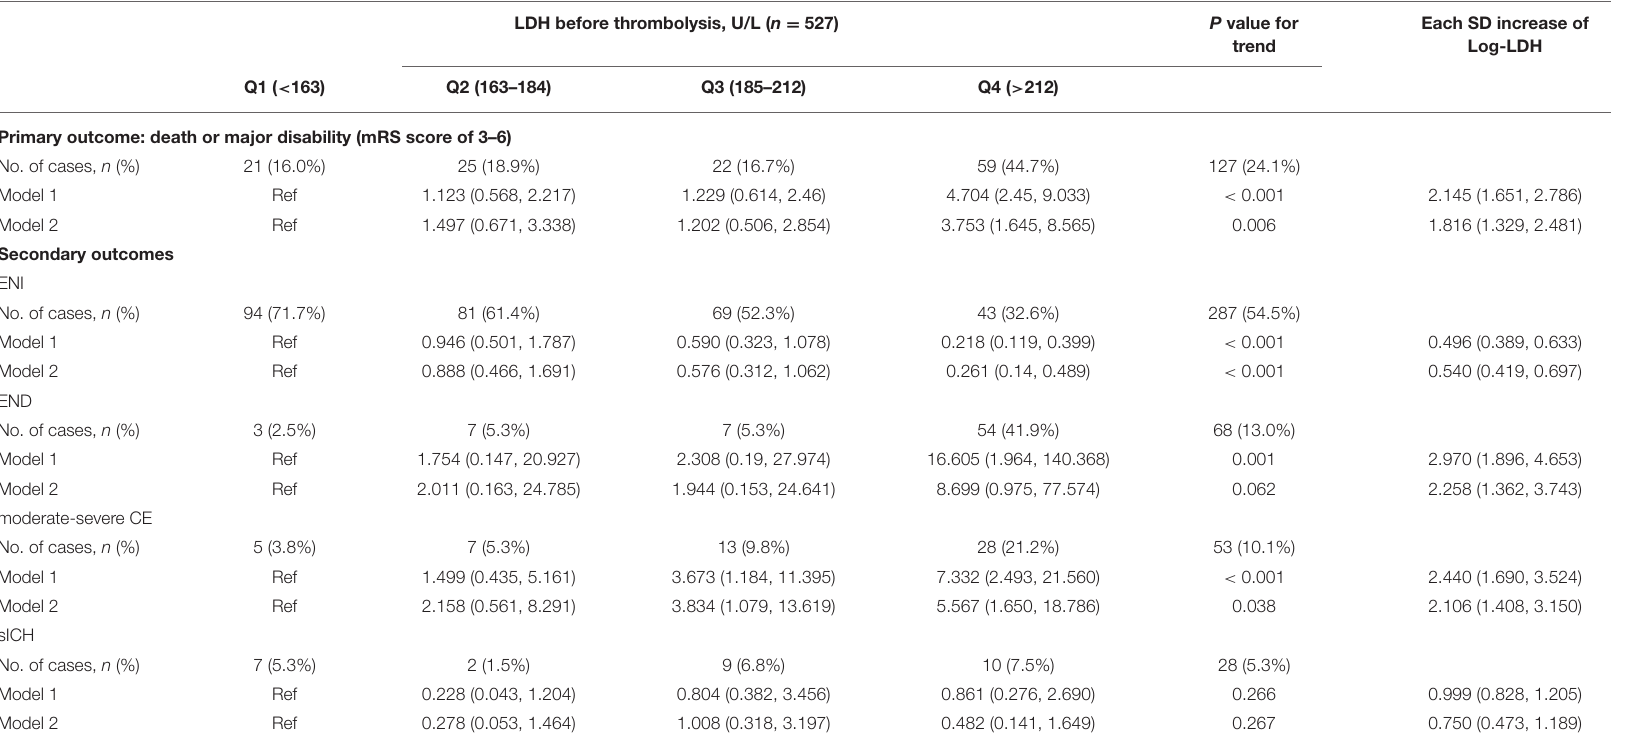
TABLE 2 | Odds ratio and 95% CI of clinical outcomes for serum LDH before thrombolysis. LDH before thrombolysis, U/L ( n = 527) P value for